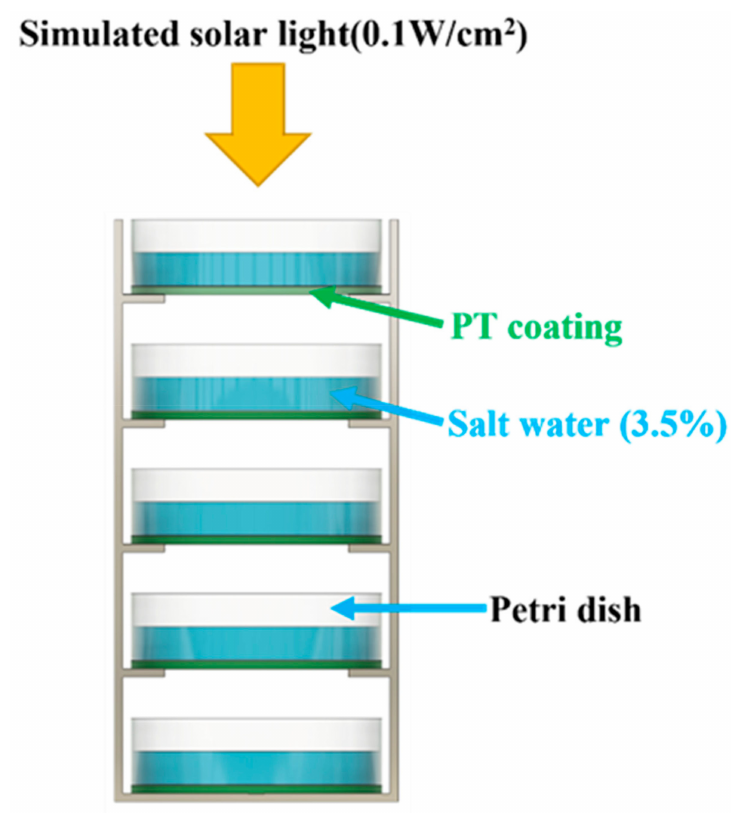
Figure 15. Schematic diagram showing the multilayer photothermal evaporation system (MPTES). To investigate the effect of surface area, we determined the mass of water evaporated as a function of time for the MPTES system containing 10 mL of 3.5 wt.% saltwater without turning on the simulated solar light. It was found that the evaporation rate of the MPTES system increased 81.2% by adding four dishes to the single-dish system due to substantial increase in the total surface area (Figure 16a). While the surface area is only 28.26 cm 2 for a single dish, it increases to 141.3 cm 2 with five dishes, an increase of 400%. These results clearly indicate the effects of multilayers on the evaporation rate without any photothermal heating.